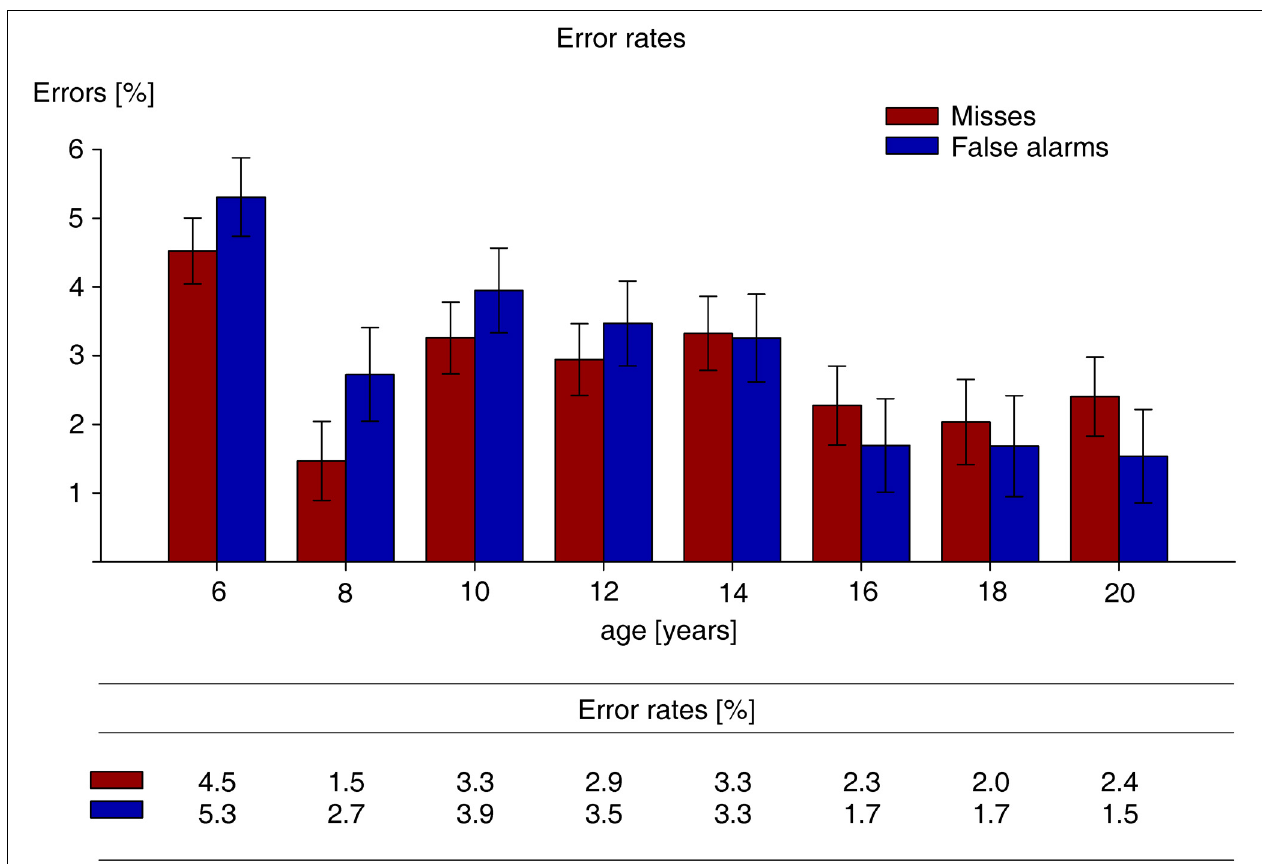
FIGURE 5 | Error rates, measured as percentage, on target-present (misses) and target-absent (false alarms) trials, separately for each age group. Error bars reflect standard error of the